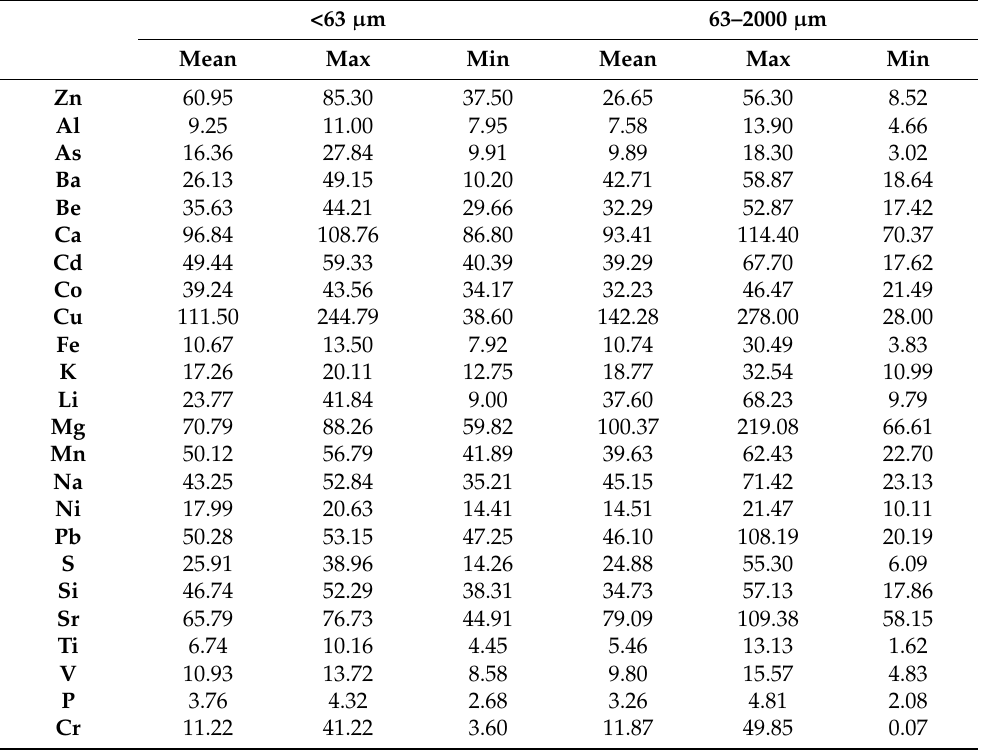
Table 5. Ratio: content of elements extracted with 2 M HNO 3 /total extracted element contents (BCR extraction) * 100 (%).